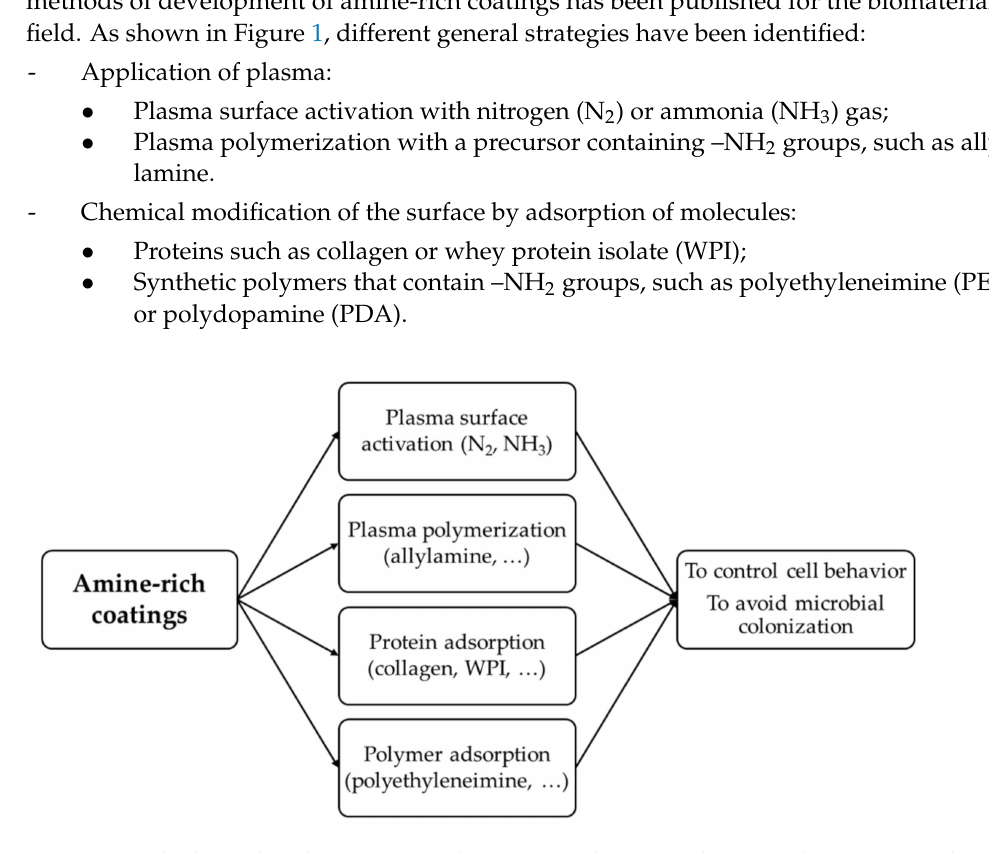
Figure 1. Methods used to obtain amine-rich coatings on biomaterials. WPI: whey protein